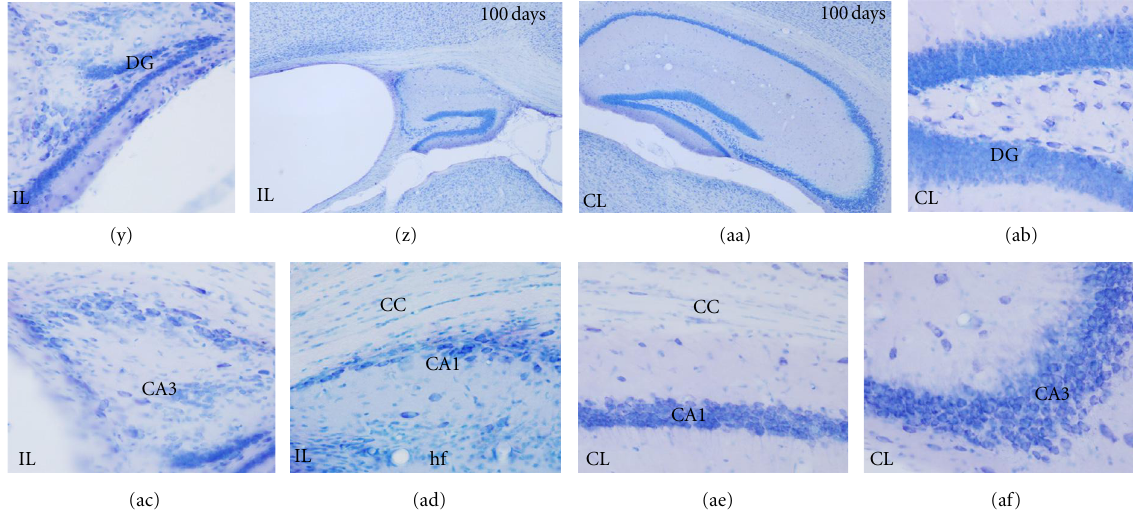
Figure 4: Nissl staining showing H/I e ff ects on the hippocampus and corpus callosum of the contralateral (CL) (right side of the panel), and ipsilateral hemisphere (IL) (left side of the panel), from 7 to 100 days (d) after hypoxia. At 7d (a–h), overall hippocampal atrophy (b), layer disruption in ipsilateral CA3 (e), and increased cellularity in the ipsilateral corpus callosum (f) are seen. At 14d (i–p) neuronal degeneration is widespread in hippocampus (i, j, m, and n). At 30 d (q–x) and 100 d (y–af), hippocampal atrophy (compare r to s, z to aa) and massive neuronal loss is seen in CA1 while CA3 is almost disorganized (r, u, and v for 30d, z, ac, and ad for 100 d), along with the disorganized DG (compare q to t, y to ab). Increased cellularity in the corpus callosum is also visible (v and ad). Scale bars (low magnifications: b, c, j, k, r, s, z, aa) = 100 μ m; scale bar in all other micrographs = 25 μ m. CA1: cornu ammonis 1; CA3: cornu ammonis 3; CC: corpus callosum; DG: Dentate